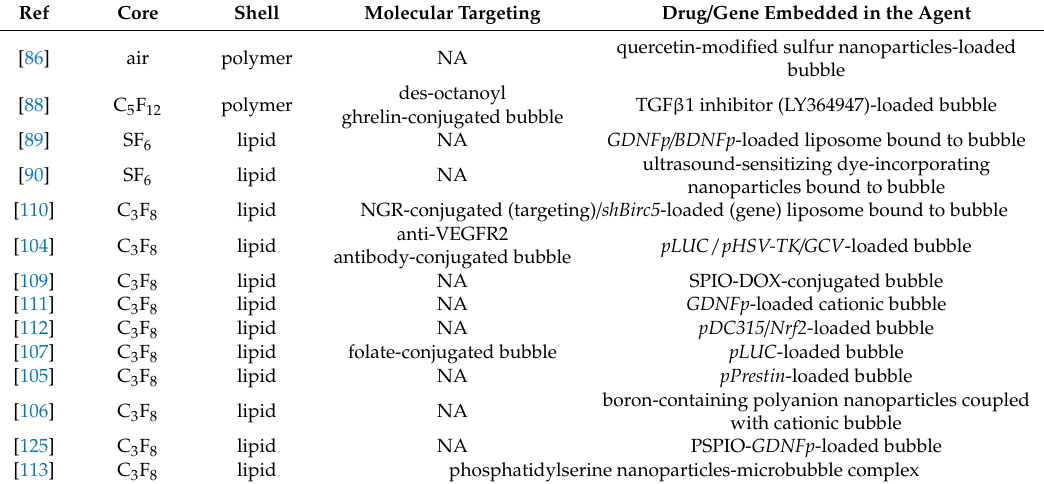
or peptides. Table 5 summarizes the di ff erent molecular targeting and drug / gene-complexed bubble options for BBB opening and therapeutic purposes found in the recent literature. Table 5. Molecular targeting and drug / gene-complexed bubble for BBB opening and therapeutic purpose.